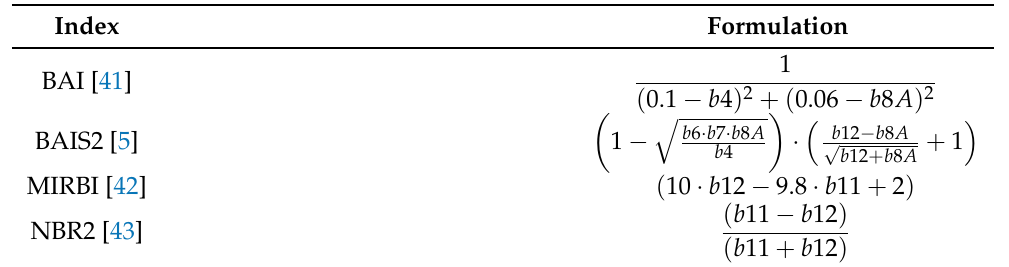
Table 2. Spectral indices used for burned area